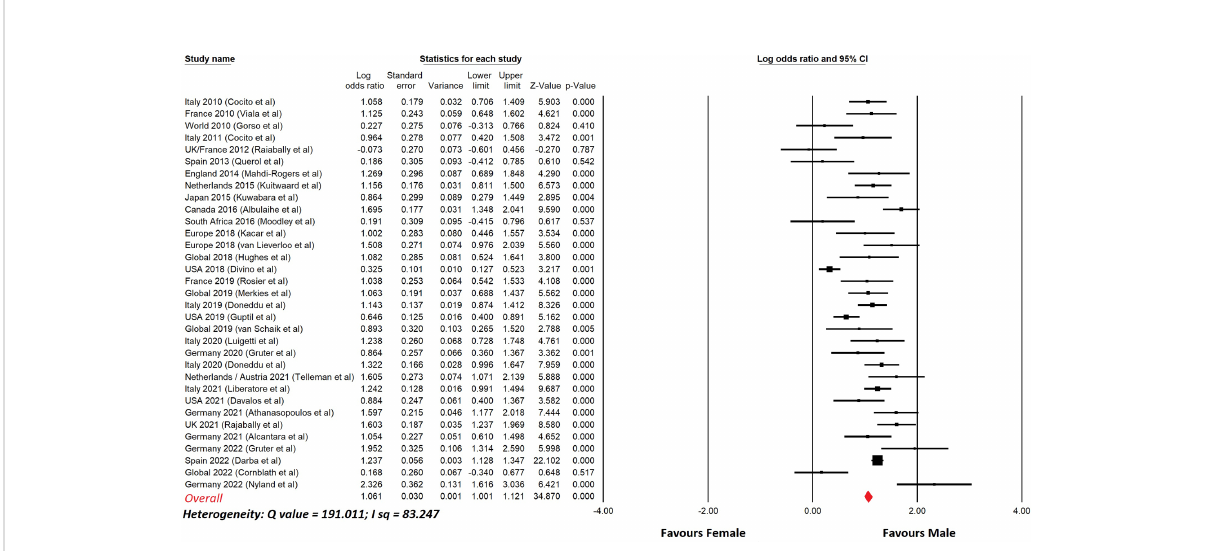
FIGURE 3 Meta-analysis of sex differences in CIDP.This shows a meta-analysis of the data from Table 6. Comprehensive Meta-analysis software v 3.31 (Biotech, USA, 2022) was used. Sex differences are displayed using a log odds ratio. The overall odds ratio was 2.9. The overall relative risk was